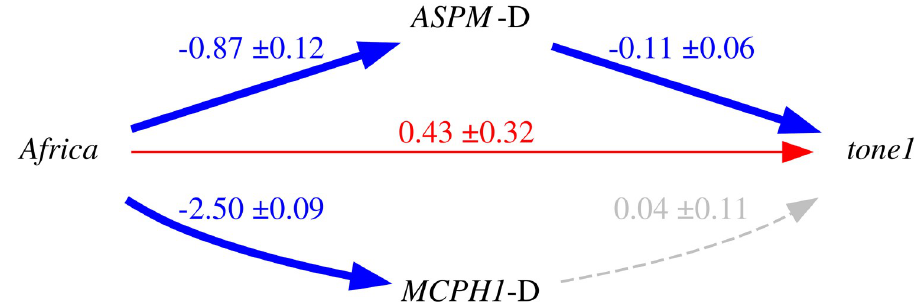
Fig 14. Summary of the 1,000 path models for tone1 fitted to restricted samples. Each edge shows the means of the standardized path coefficients and ± their standard deviation; conventions as in Fig 13.